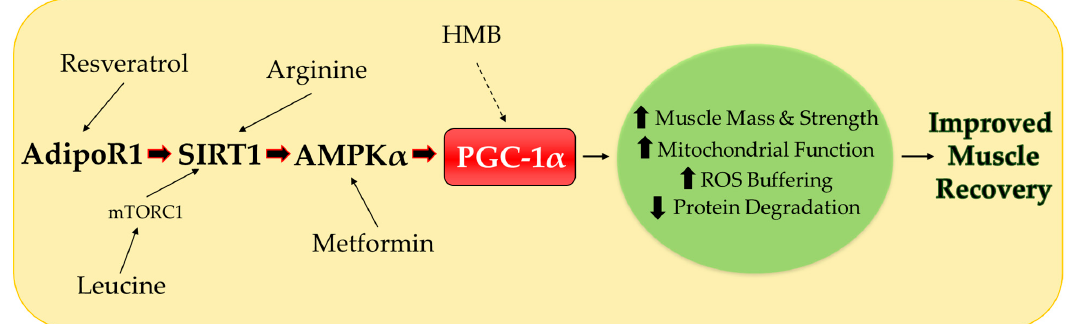
Figure 2. Proposed role of translational approaches on skeletal muscle SIRT1–AMPK α –PGC-1 α signaling in preventing muscle disuse atrophy and promoting recovery in aging. Leucine,